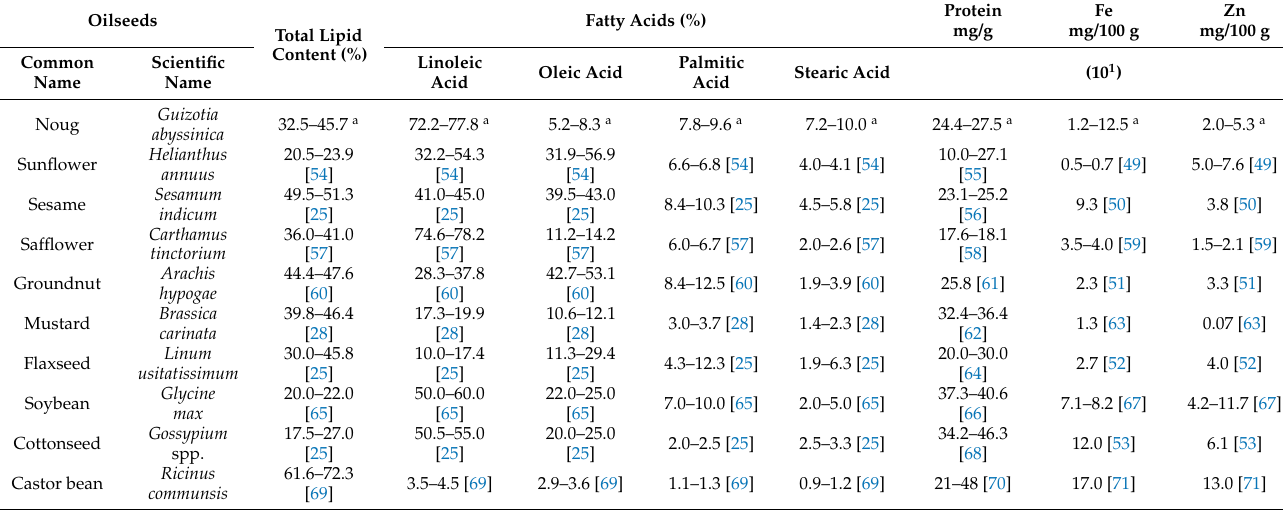
Table 5. Content of total lipids, fatty acids, protein, Fe, and Zn in major oilseed crops